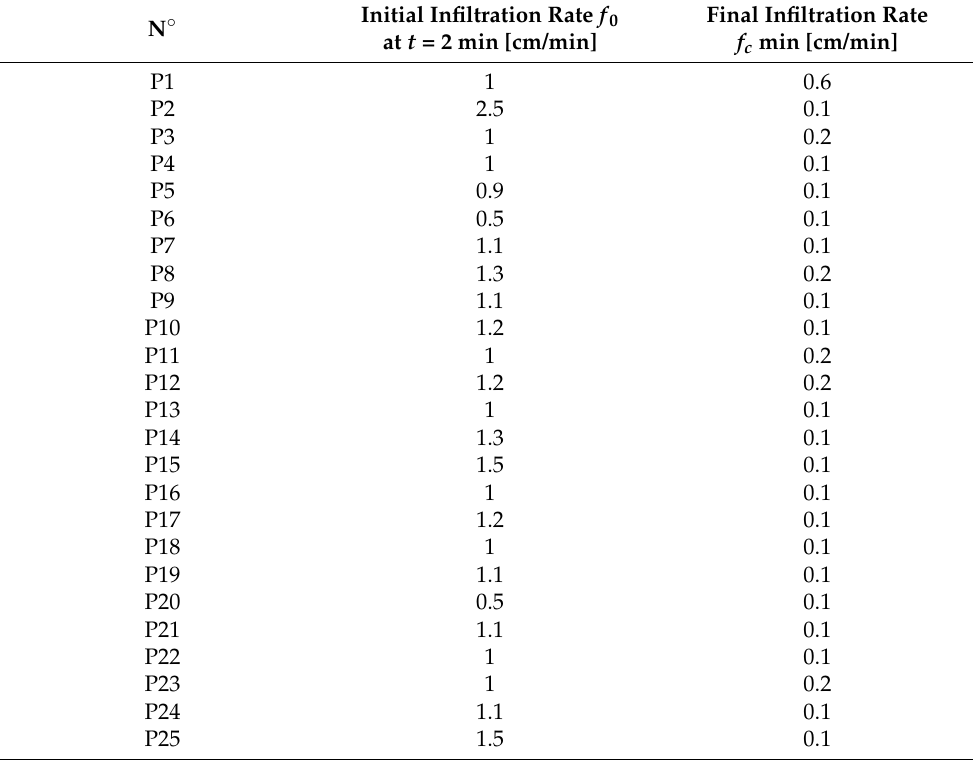
Table 2. Initial and final infiltration rates for Madjez Ressoul